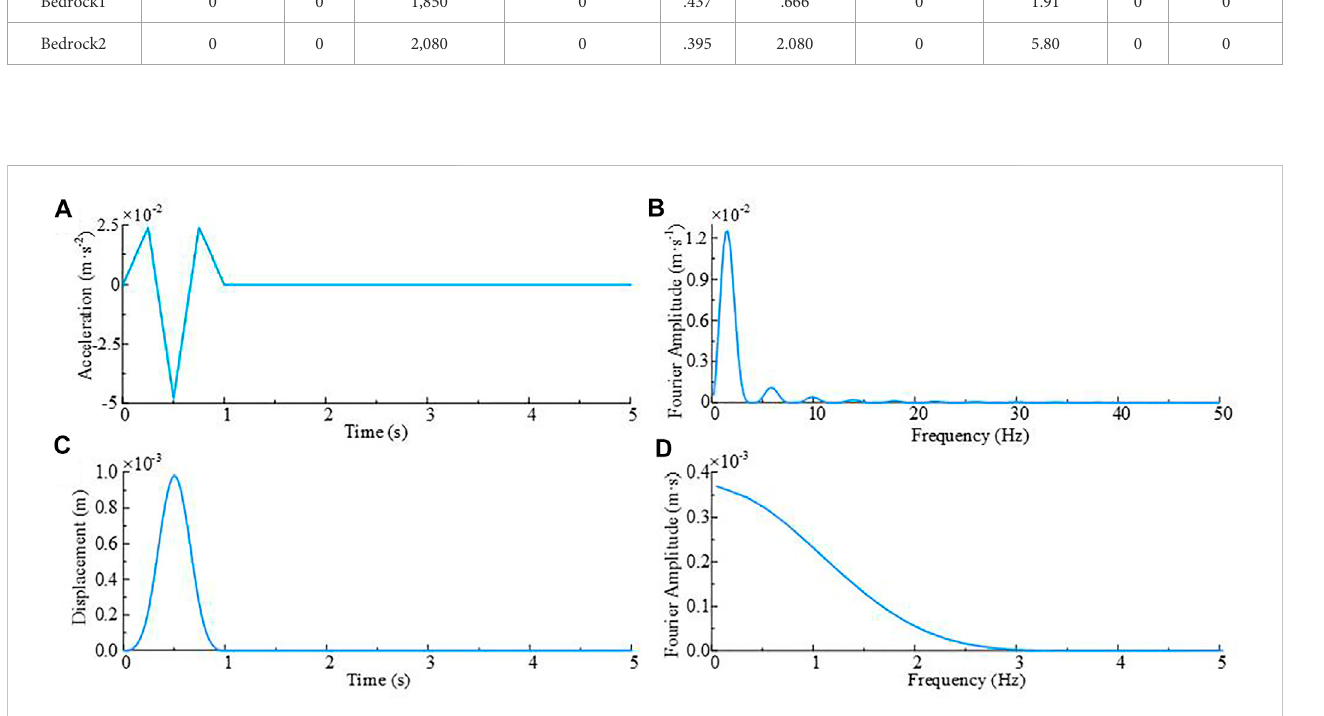
FIGURE 8 Input pulse wave: (A) Acceleration time history; (B) Acceleration Fourier amplitude spectrum; (C) Displacement time history; (D) Displacement Fourier amplitude spectrum.